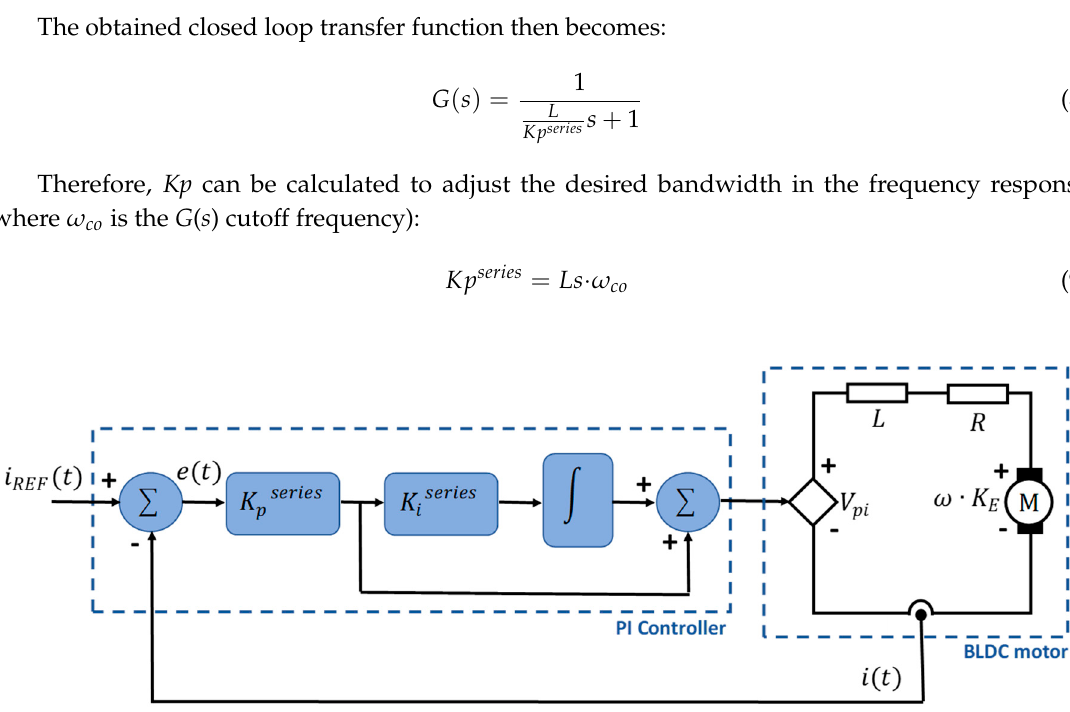
Figure 8. Implementation of the FOC algorithm. In red, analog input data. In green, digital signals with 32-bit resolution in floating point. In blue, pulse-width modulation (PWM) output signals.